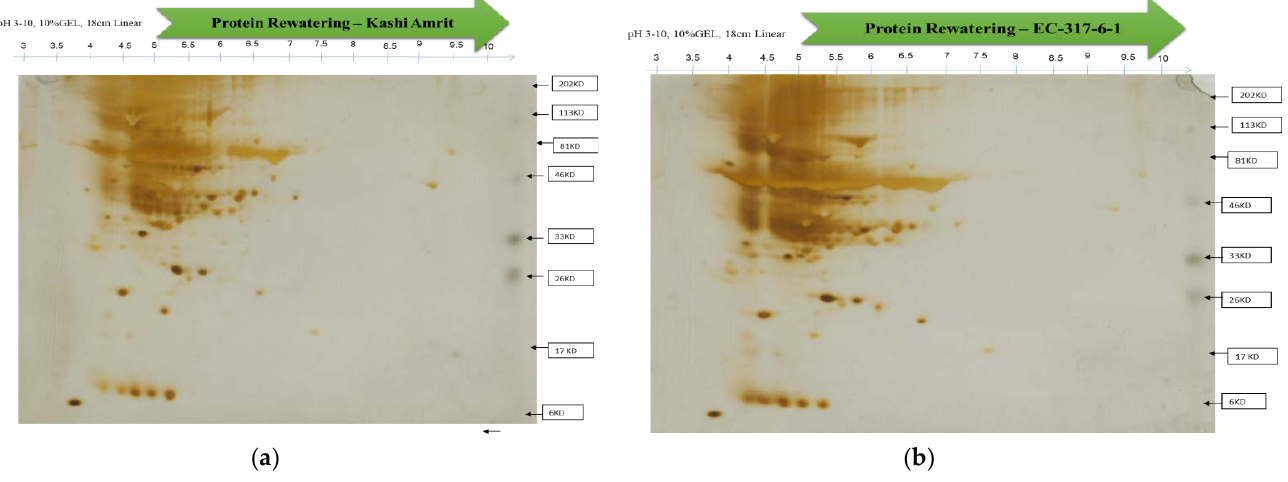
Figure 4. 2-D gel electrophoresis of proteins isolated from Kashi Amrit ( a ) and EC-317-6-1 ( b ) under rewatering conditions.